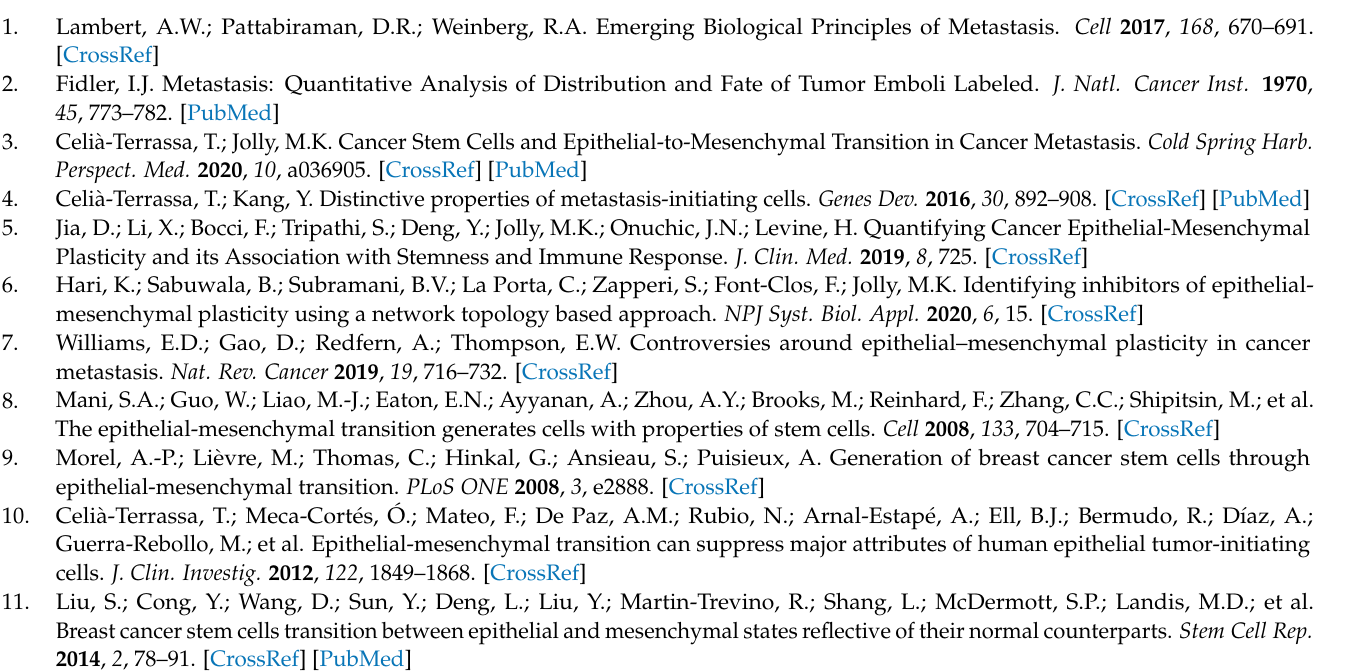
Table S7: Statistical Testing results for differences of the node distributions across the clusters for a single replicate of the base circuit, Table S8: Statistical Testing results for the PSF circuits with the proportions calculated for all the replicates of the de10 circuit forming one comparison group while the proportions of all the replicates of the oe10 circuit forming the other comparison group, Table S9: p1 and p2 for solutions of multi-stable systems (after removing monostable systems), Table S10: Different configurations of the association of stemness with the different phenotypes in bistable phases for base circuit, Table S11: Different configurations of the association of stemness with the different phenotypes in tristable phases for base circuit, Table S12: Different configurations of the association of stemness with the different phenotypes in bistable phases for GRHL2 circuit (reference un-perturbed), Table S13: Different configurations of the association of stemness with the different phenotypes in tristable phases for GRHL2 circuit(reference un-perturbed), Table S14: Different configurations of the association of stemness with the different phenotypes in bistable phases for OVOL circuit(reference un-perturbed), Table S15: Different configurations of the association of stemness with the different phenotypes in tristable phases for OVOL circuit(reference un-perturbed), Table S16: Different configurations of the association of stemness with the different phenotypes in bistable phases for NRF2 circuit(reference un-perturbed), Table S17: Different configurations of the association of stemness with the different phenotypes in tristable phases for NRF2 circuit(reference